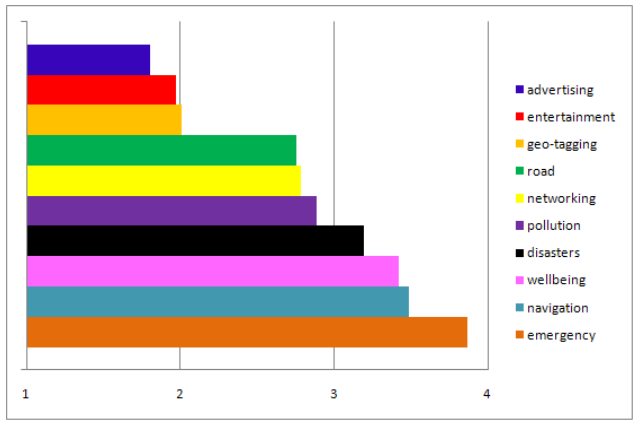
Figure 5. LBS significance for the end user, measured as willingness to pay extra compared to the current monthly fee; average values: ( 1 ) maximum 0% extra; ( 2 ) maximum 1% extra; ( 3 ) maximum 5% extra; and ( 4 ) maximum 10%